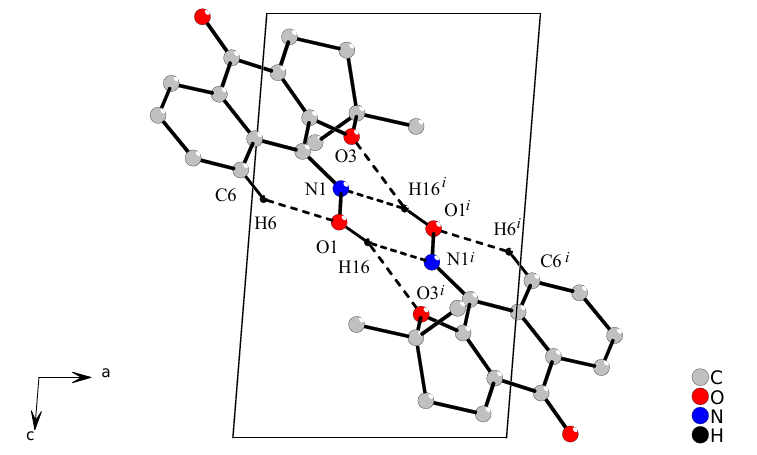
Figure 3. View of the centrosymmetric R 22 (6) dimers in (101) plane by intra- and intermolecular interactions. [Symmetry code ( i ) = 1- x , 2- y , 1- z ]